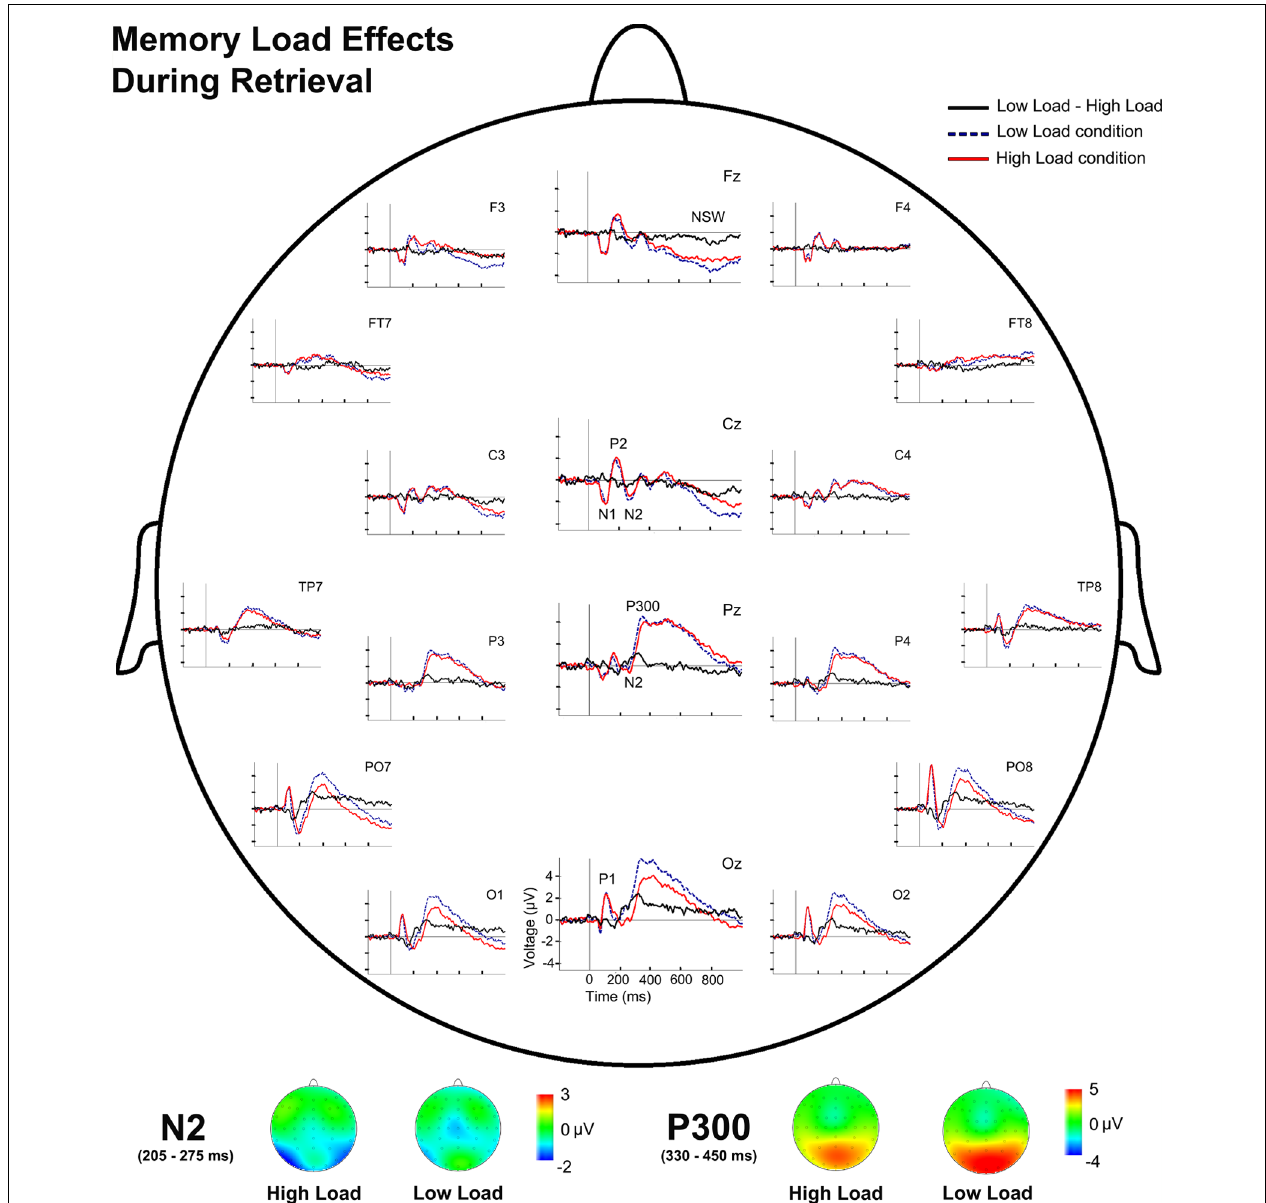
FIGURE 5 | Event-related potentials waveforms during probe stimulus processing and voltage maps for components modulated byWM load. (Top) Topographic plot of the ERP waveforms for bothWM load conditions and their difference (LL-HL) during retrieval at several scalp electrodes. (Bottom) N2 and P300 voltage maps for bothWM load conditions during